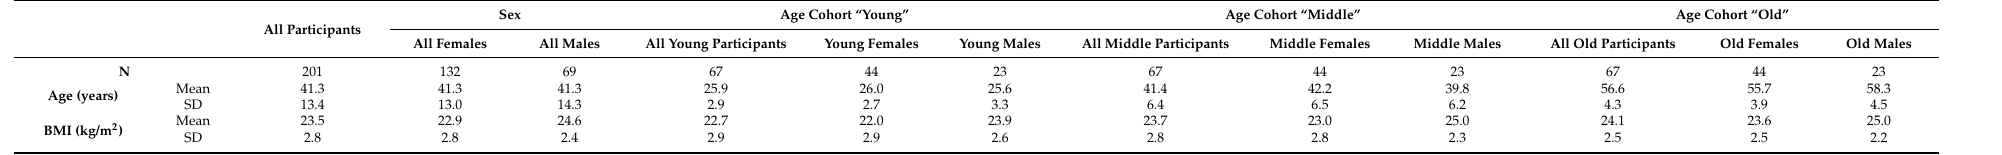
Table 1. Participant characteristics.